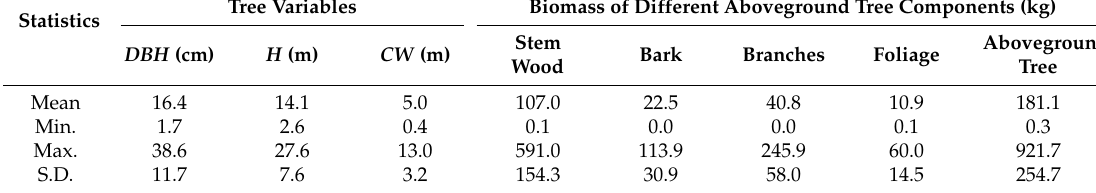
Table 1. Tree characteristics and summary statistics of the aboveground biomass components for poplar ( n = 80) in Jiangsu Province of